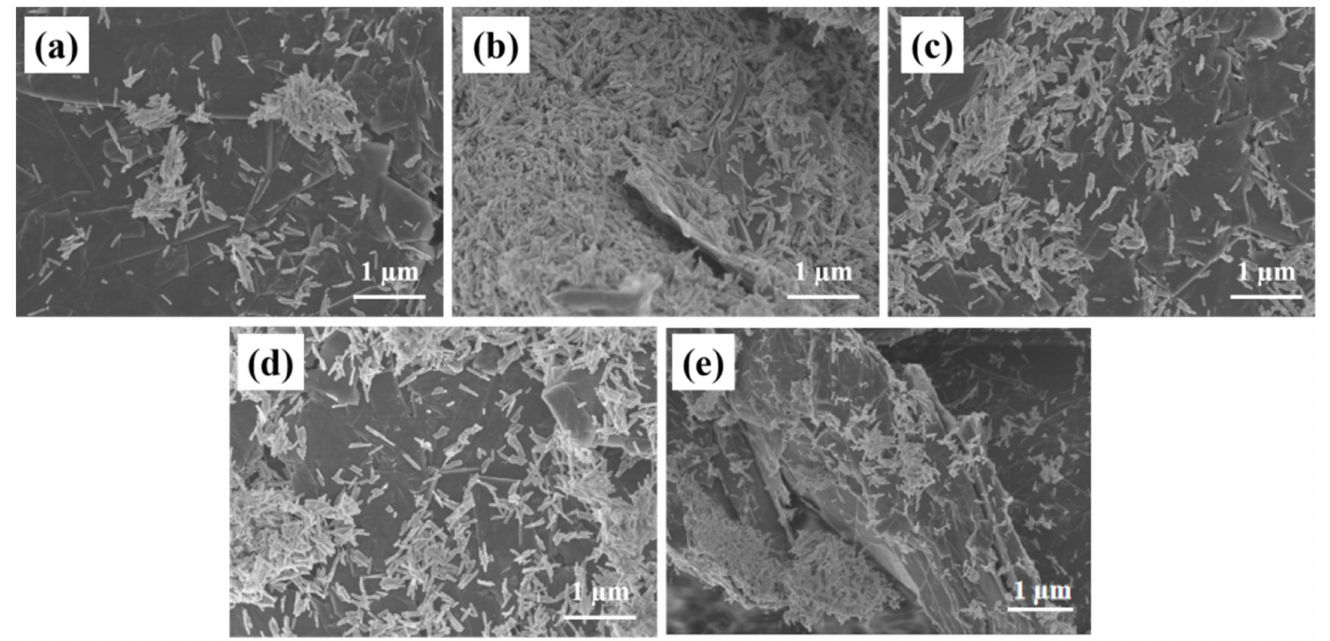
Figure 2. SEM images of rGO/Fe 2 O 3 -175 ◦ C with different graphene ratios ( a ) 0.1; ( b ) 0.2; ( c ) 0.3; ( d ) 0.4; ( e ) 0.5.